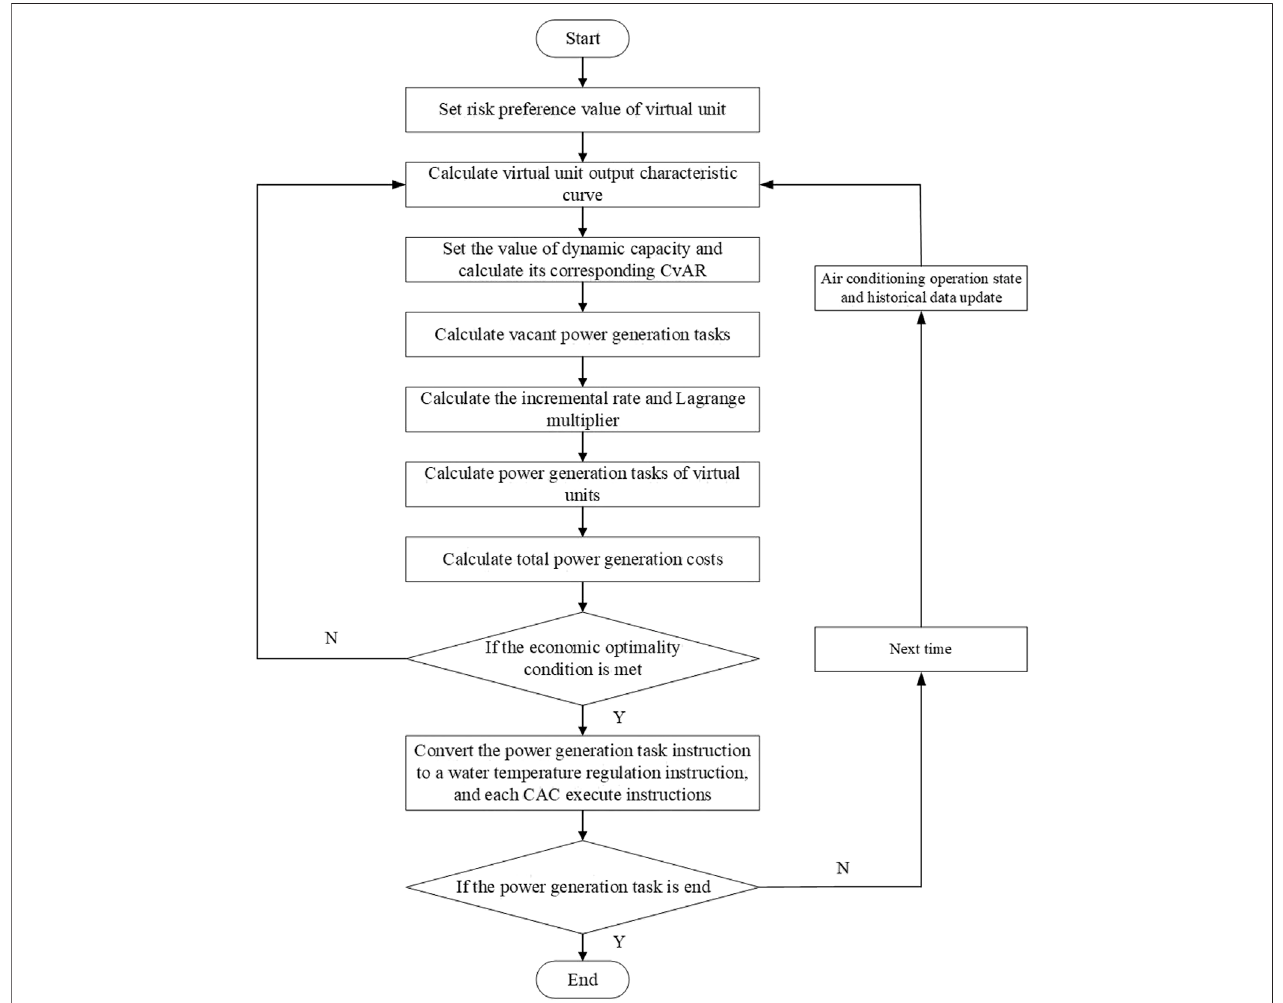
FIGURE 6 | Algorithm fl ow chart of VPP operation